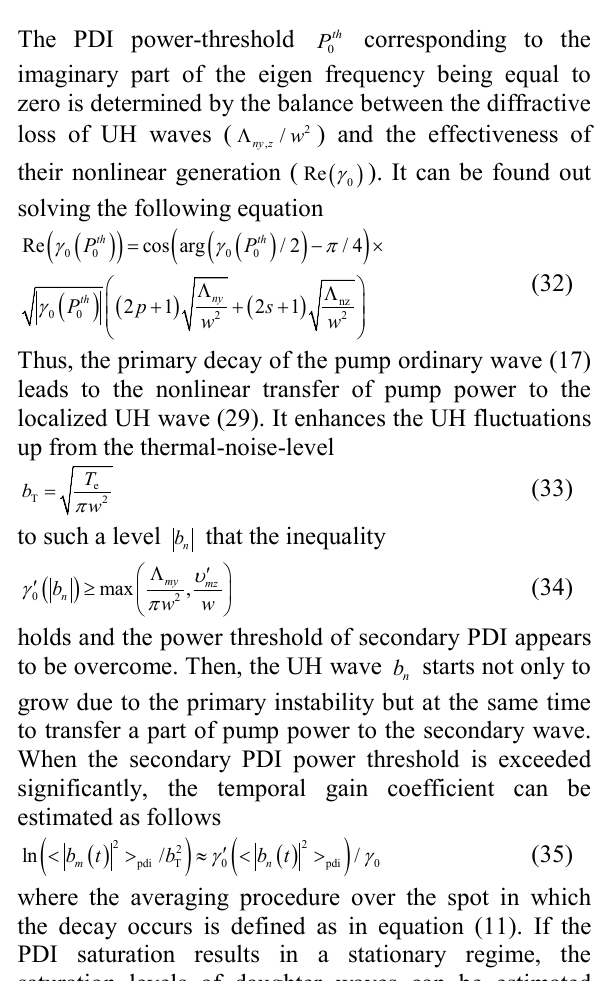
Fig. 3. The spatial distribution of UH wave . Zoom gives the comparison of the function derived numerically with the analytical dependence